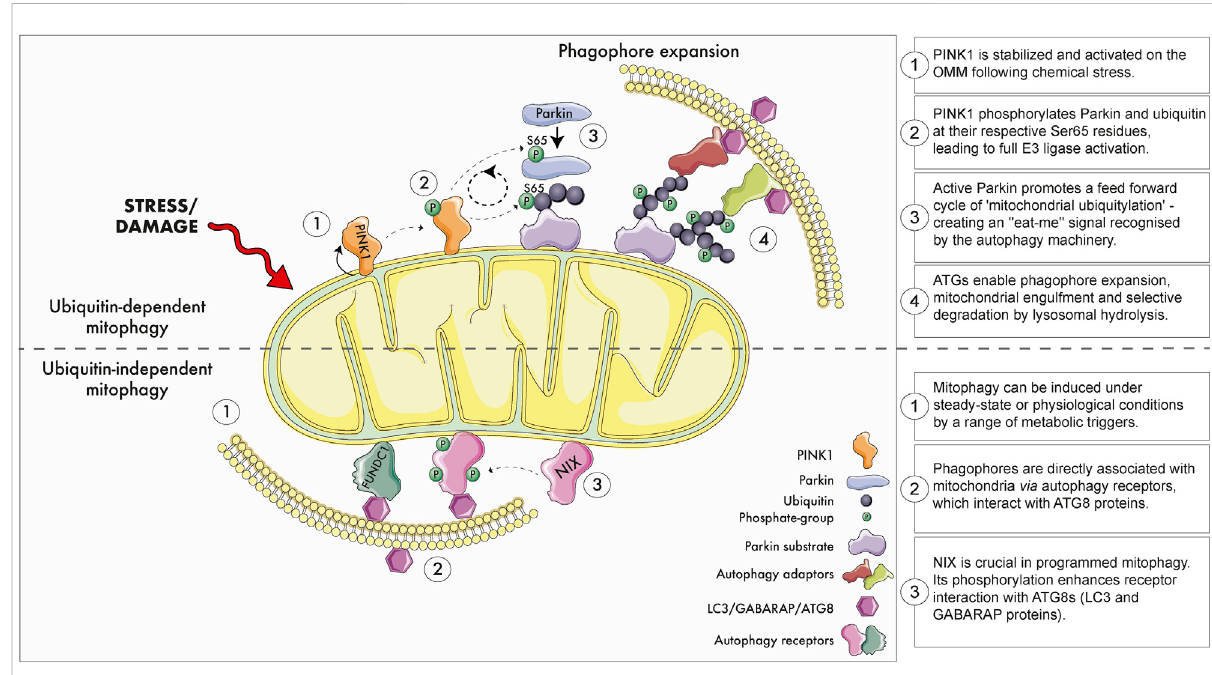
FIGURE 2 Ubiquitin dependent and independent mitophagy. Upper panel: The best studied ubiquitin-dependent mitophagy mechanism is the PINK1- Parkin-dependent pathway. Brie fl y, extreme chemical stress promotes mitochondrial damage which triggers PINK1 stabilisation and activation on theoutermitochondrialmembrane(OMM).PINK1recruitsubiquitinandtheE3ligaseParkintothemitochondriaandphosphorylatestheirrespective Ser65 residues. Feed-forward ampli fi cation cycle signals result in coating of damaged mitochondria with ubiquitin, which promotes the recruitment of autophagy adaptors, phagophore biogenesis and engulfment. Engulfed mitochondria within autophagosomes are destroyed upon fusion with acidic endolysosomal subcompartment. Although PINK1 and Parkin promote mitochondrial clearance in cultured proliferating cells, severalstudies demonstrate thispathway doesnotregulatephysiologicalmitophagywithintissues. Lowerpanel: Ubiquitin-independentmitophagy. Basal and programmed mitophagy occur in tissues, likely in response to altered metabolic demands, states of insults that damage mitochondria. Phagophoresformonmitochondriathroughtheinteractionofselectiveautophagyreceptors(e.g.,NIX,FUNDC1) withATG8proteins.NIX/BNIP3L is especially important during programmed mitophagy and metabolic maturation. NIX/BNIP3L phosphorylation enhances its association with ATG8 proteins. Loss of NIX/BNIP3L alters physiological mitophagy in the retina and reticulocytes. Several of the most promising therapeutic strategies to modulate mitophagy operate via ubiquitin-independent